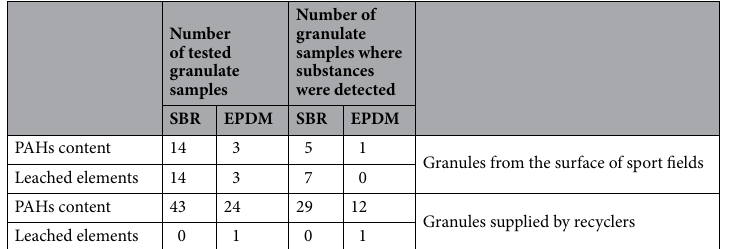
Table 3. Summarized number of granulate samples in which PAHs content and leached elements were detected.